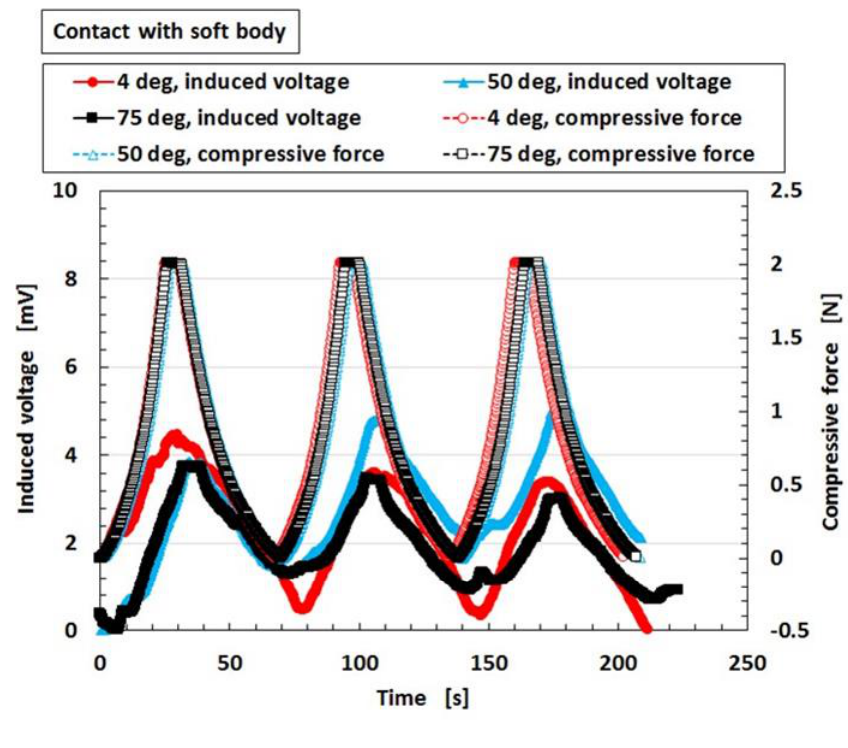
Figure 18. Induced voltage of MCF rubber sensor with single layer produced by combination of PDMS and PVA in water by compression: ( a ) to a hard body ( b ) to a soft body.